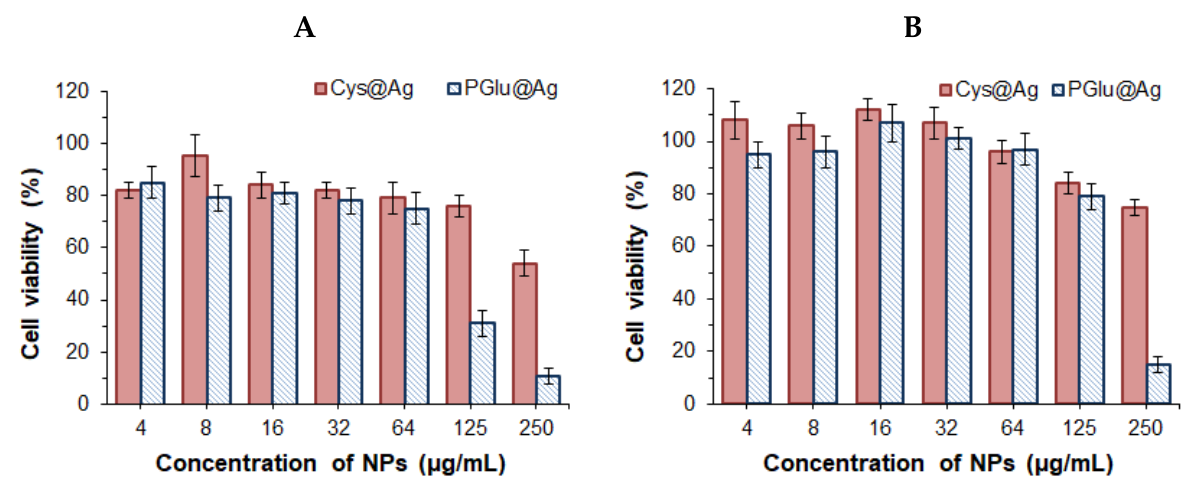
Figure 5. Viability of HEK 293 ( A ) and HepG2 ( B ) incubated with hybrid nanoparticles for 72 h. In the case of Cys@Ag NPs, the IC 50 values for normal (HEK 293) and cancer (HepG2) cells were 284.4 ± 9.8 and 342.1 ± 16.7 µ g/mL, respectively. In turn, IC 50 values